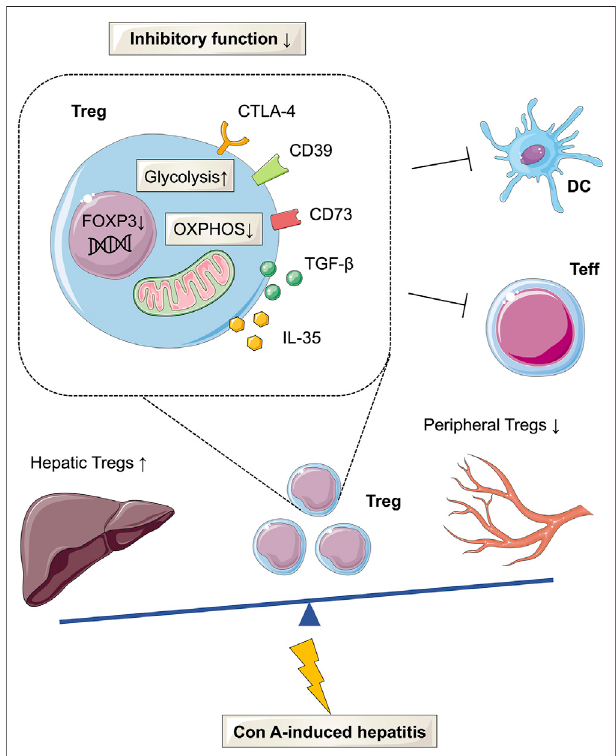
FIGURE 5 | Glucose metabolism reprogramming of Tregs in Con A-induced hepatitis. The frequency of Tregs was decreased in the peripheral but increased in the liver tissues of AIH patients and mouse models. In Con A-induced immune hepatitis, Tregs are functionally impaired and show enhanced glycolysis and decreased